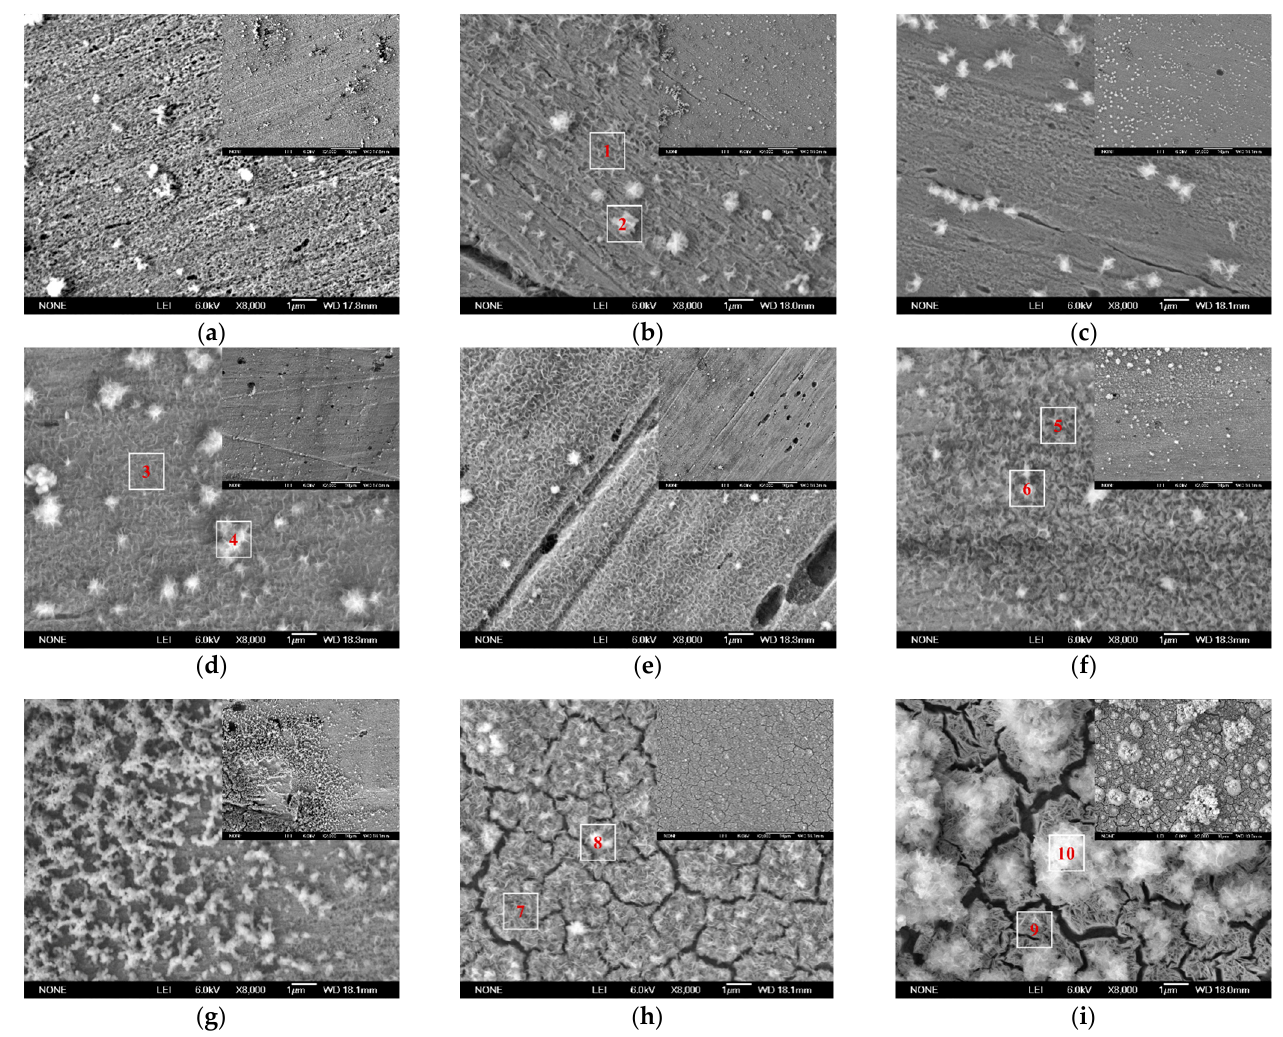
Figure 5. The morphology of corrosion products at the light-gray area under different corrosion time conditions: ( a ) 10 min, ( b ) 20 min, ( c ) 40 min, ( d ) 80 min, ( e ) 2 h, ( f ) 3 h, ( g ) 4 h, ( h ) 5 h, ( i ) 7 h. ( 1, 2, 3, 4, 5, 6, 7, 8, 9 and 10 are the EDS scanning